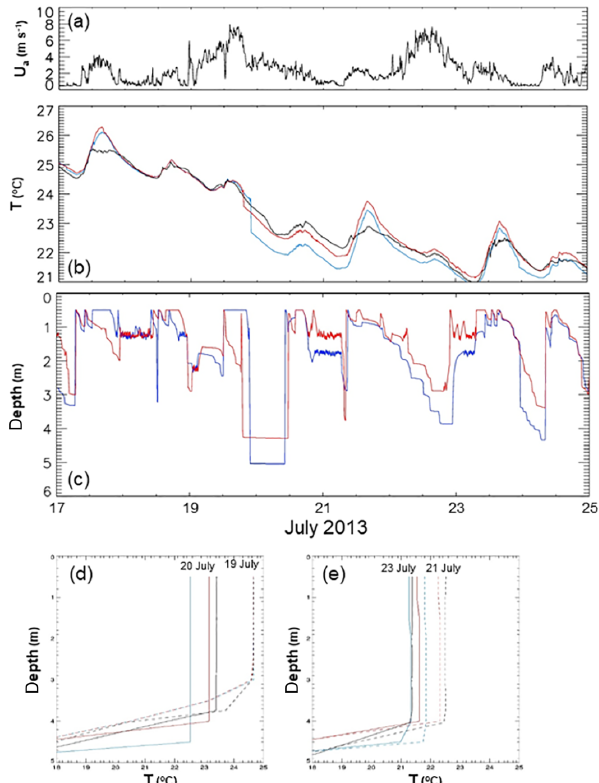
Figure 3. Observed 2m wind speed (a) , observed and simulated 0.5m water temperatures (b) , and simulated diurnal turbulent mixed layer depths (c) for 17–25 July 2013. Temperature profiles (mid- night) for (d) 19 July (dash) and 20 July (solid); and (e) 21 July (dash) and 23 July (solid). Standard simulation results (blue curves) taken from MacKay et al. (2017). Modified simulation results (red curves) have a surface drag coefficient reduced by 50%. Observed curves are